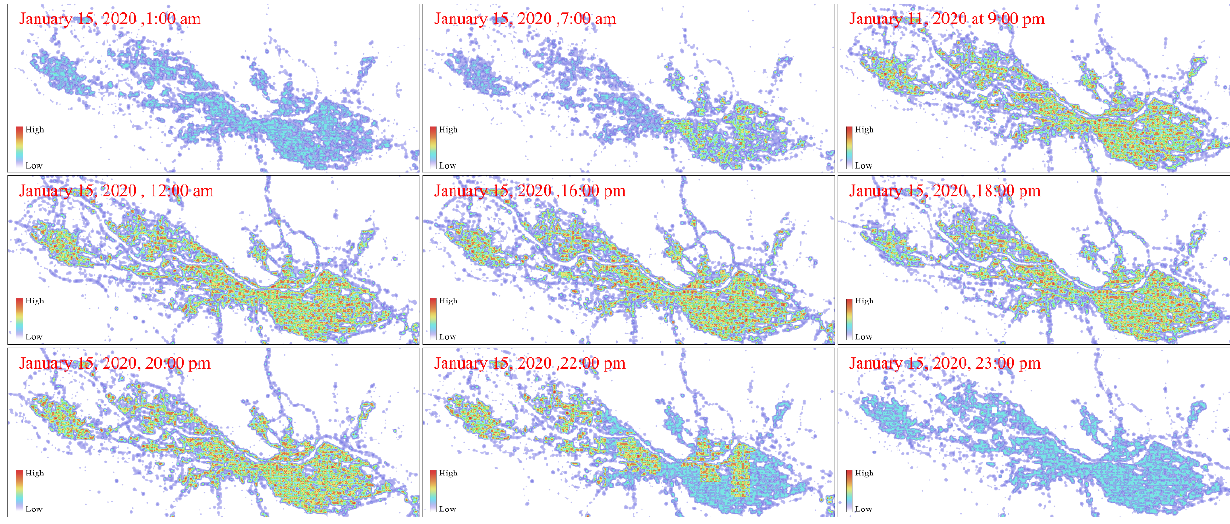
Figure 2. Baidu heatmaps of the study